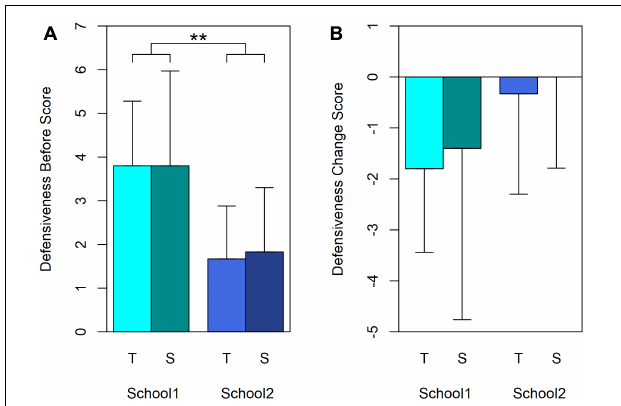
FIGURE 7 | Mean scores and standard deviations for the interaction between Treatment groups and Sex in the Defensiveness scale of the CFSEI-3. (A) Before scores. (B) Change scores. The data are arranged to highlight differences between Treatment groups and schools, rather than Sex. Cyan bars: mean scores for School1. Blue bars: mean scores for School2. T, Turn-taking; S, Synchrony. Asterisks between bars for the two schools mark the significant interaction in the Treatment group × Sex ANOVA ( p = 0.008). Unlike other tests in this study, a low score is preferable, and hence a larger negative Change shows improvement (less